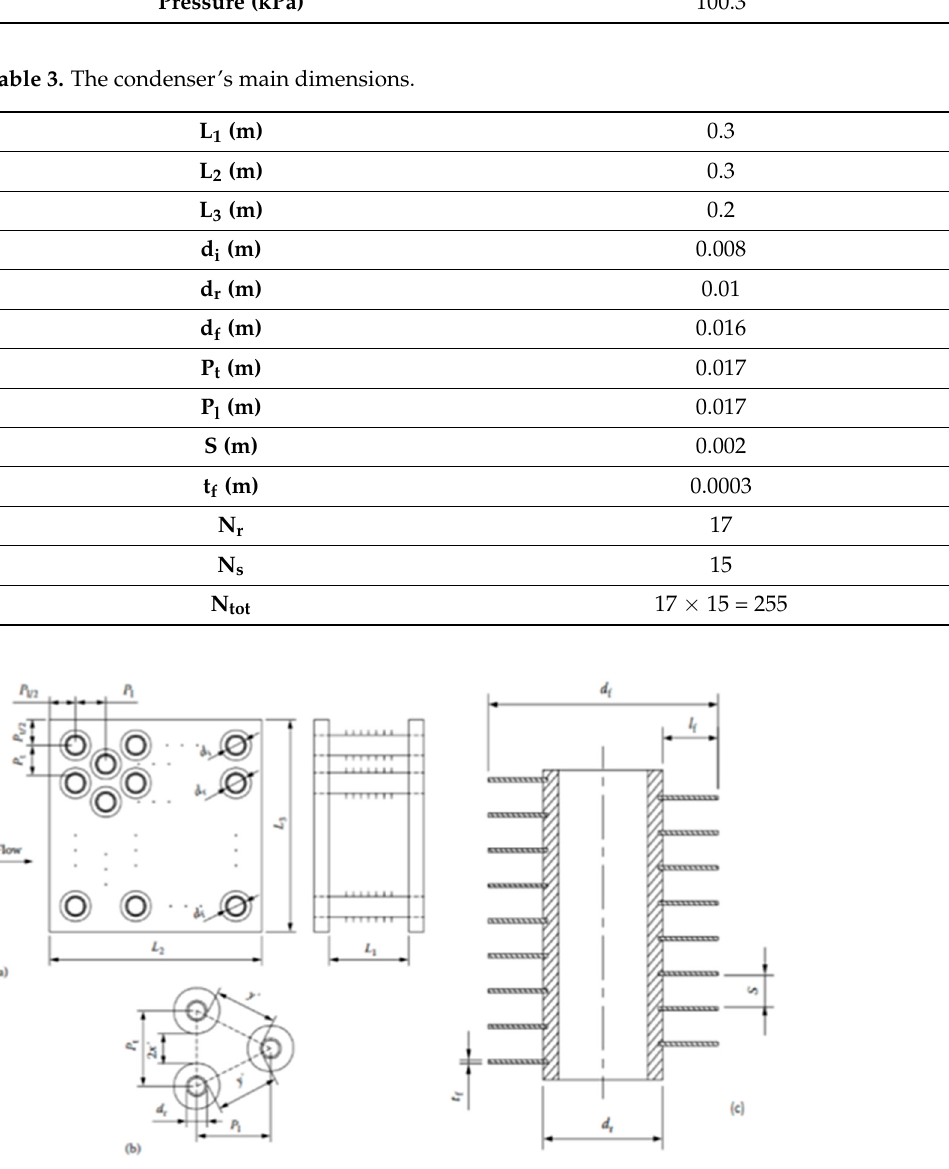
Figure 6. The condenser’s chosen configuration. ( a ) actual disposition in the condenser assembling, ( b ) triangular configuration characteristics, ( c ) finned pipe representation